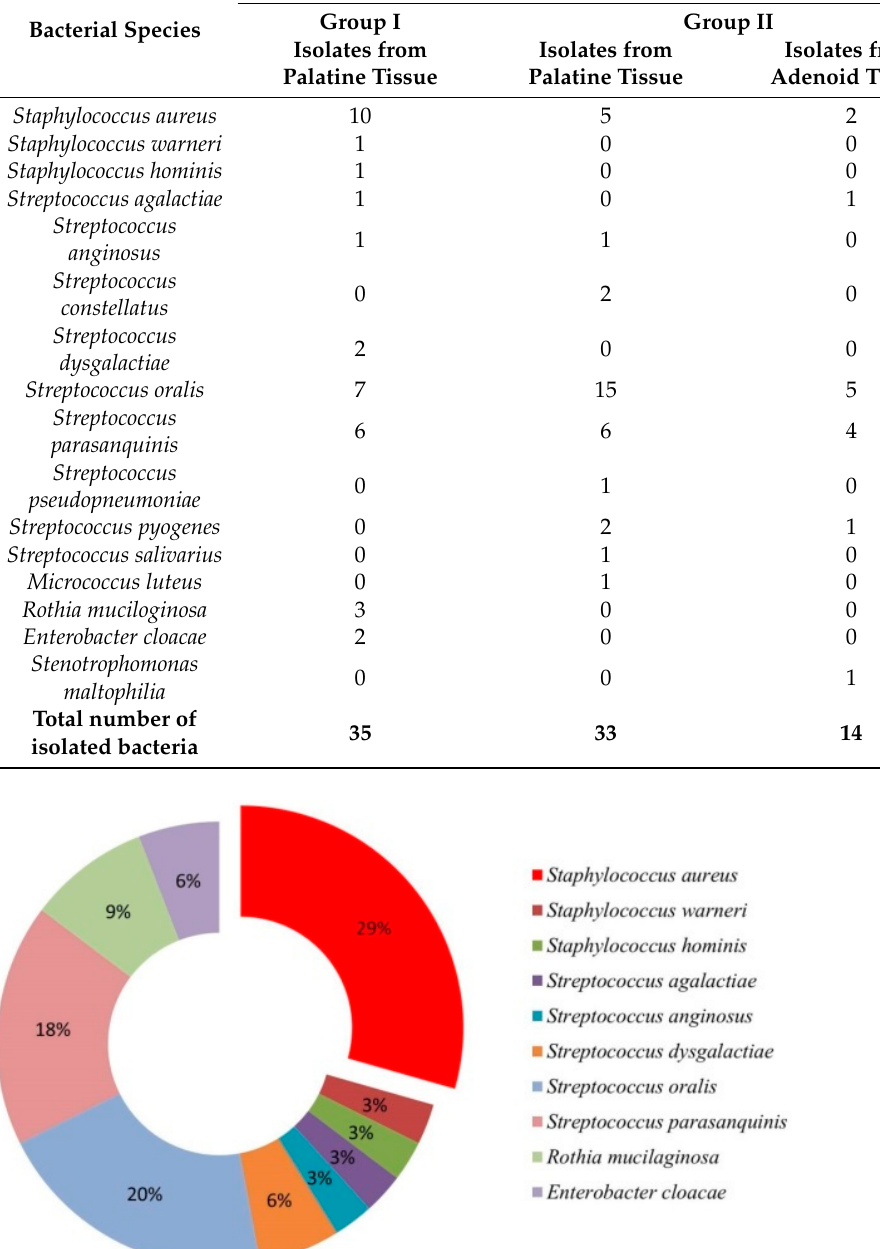
Table 3. Bacteria isolated from palatine and adenoid tissue from patients with chronic tonsillitis.